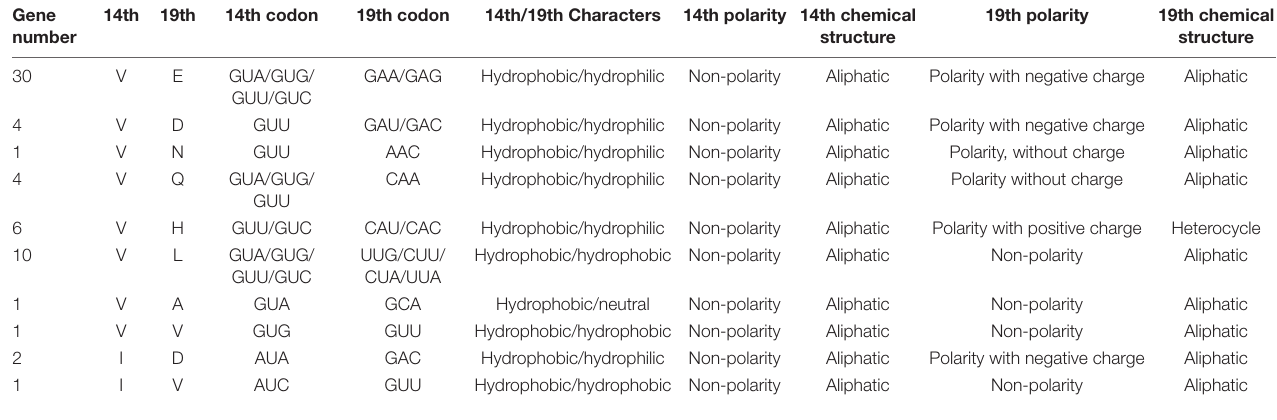
TABLE 1 | The 14th/19th amino acid analysis of the DREB subfamily AP2